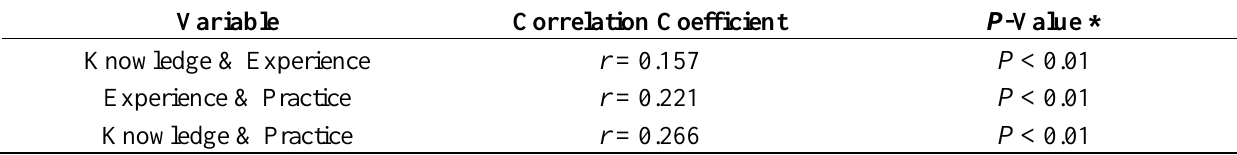
Table 4. Correlation among knowledge, experience and practice